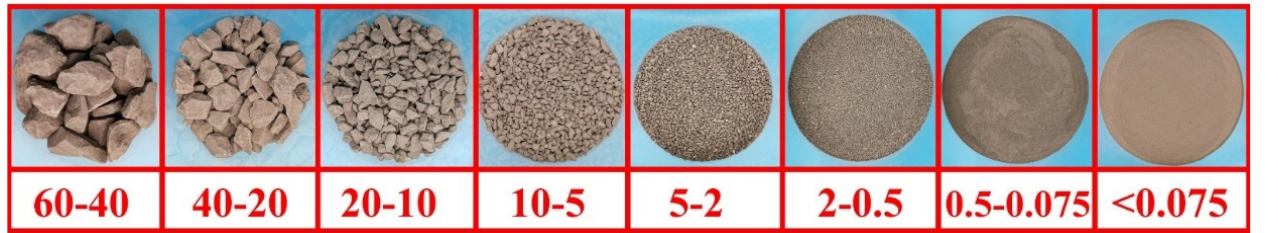
Figure 2. Coal gangue particles after sieving tests.